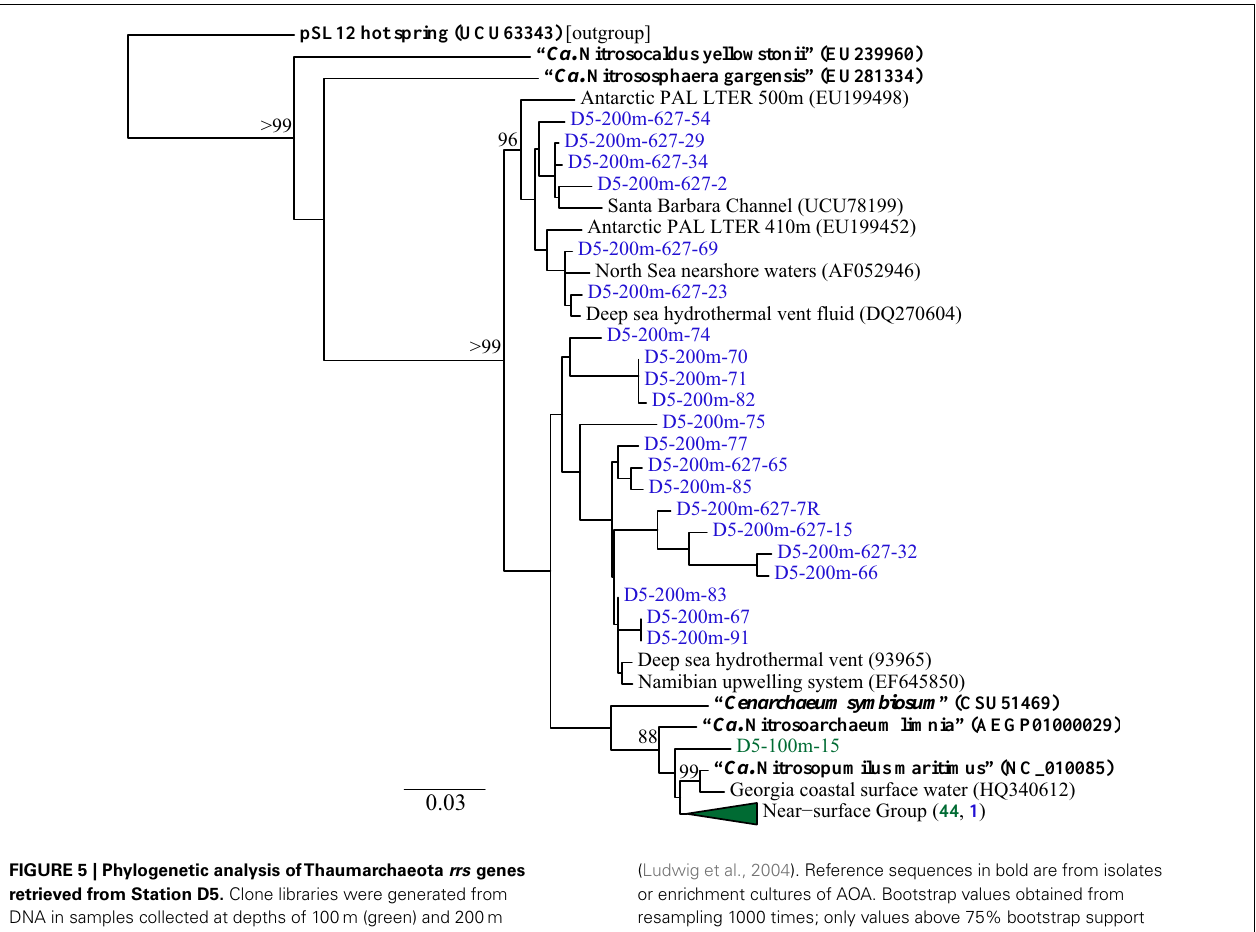
FIGURE 5 | Phylogenetic analysis ofThaumarchaeota rrs genes retrieved from Station D5. Clone libraries were generated from DNA in samples collected at depths of 100m (green) and 200m (blue).The Neighbor-Joining tree was constructed using ARB